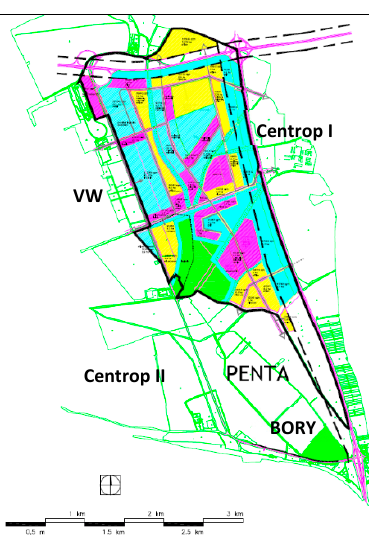
Figure 3. Example of a land-use plan ( left ) and zones for traffic planning ( right ) ( Legend: Colours on the left side has no relevant meaning. The colours of the zones and their numbering on the right side represent the areas with names on the left).